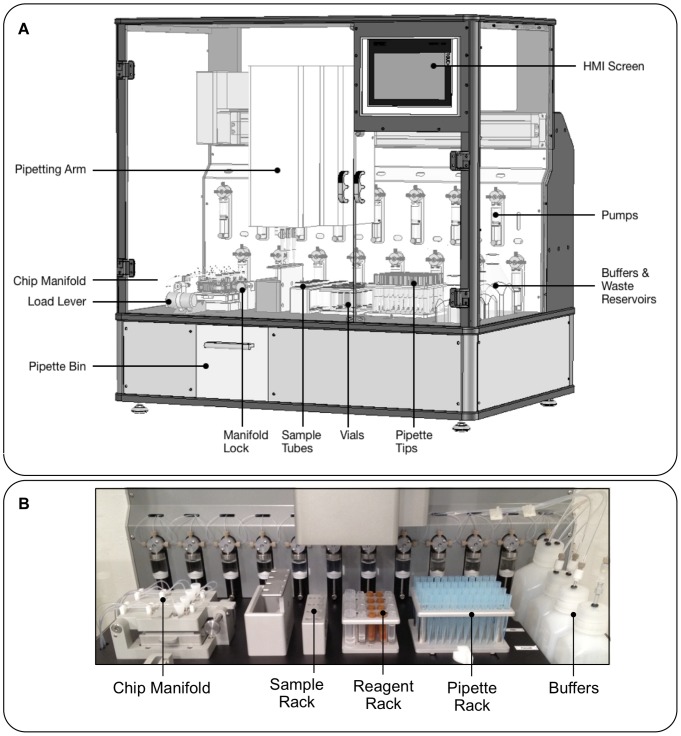
LiquidBiopsy automated platform.(A) Diagram of the LiquidBiopsy platform. (B) Closeup of the platform worksurface. A X-Y pipetting arm with 4 pipettor heads transfers sample, buffers and antibody stains into 4 flow cells in the manifold. Sheath buffers are controlled by pumps on the rear wall of the platform.